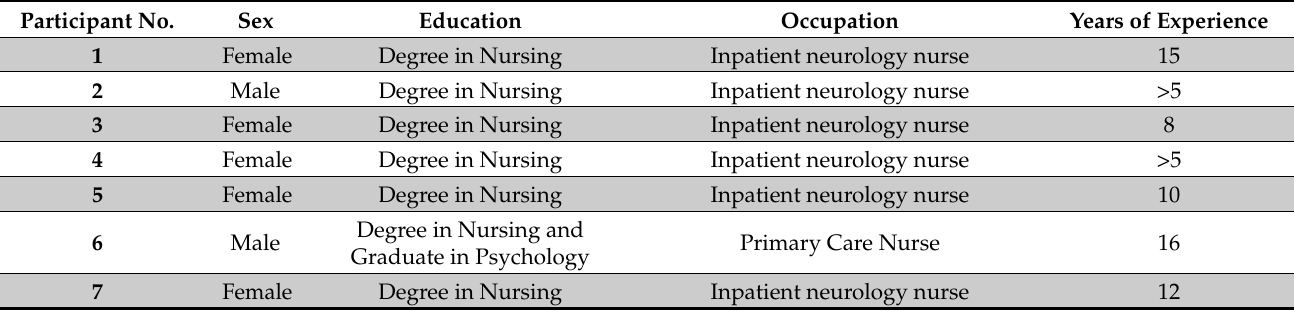
Table 2. Socio-demographic data of